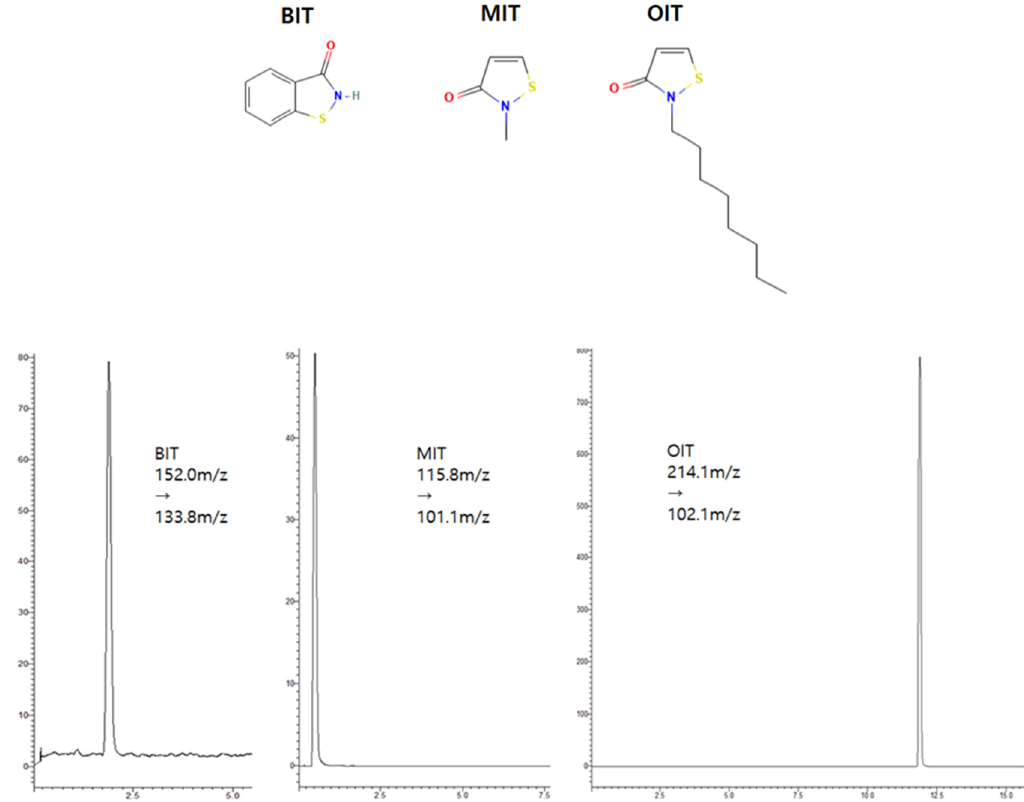
Figure 3. Structure and representative LC-MS/MS chromatograms of BIT, MIT, and OIT at 500 ng/mL .